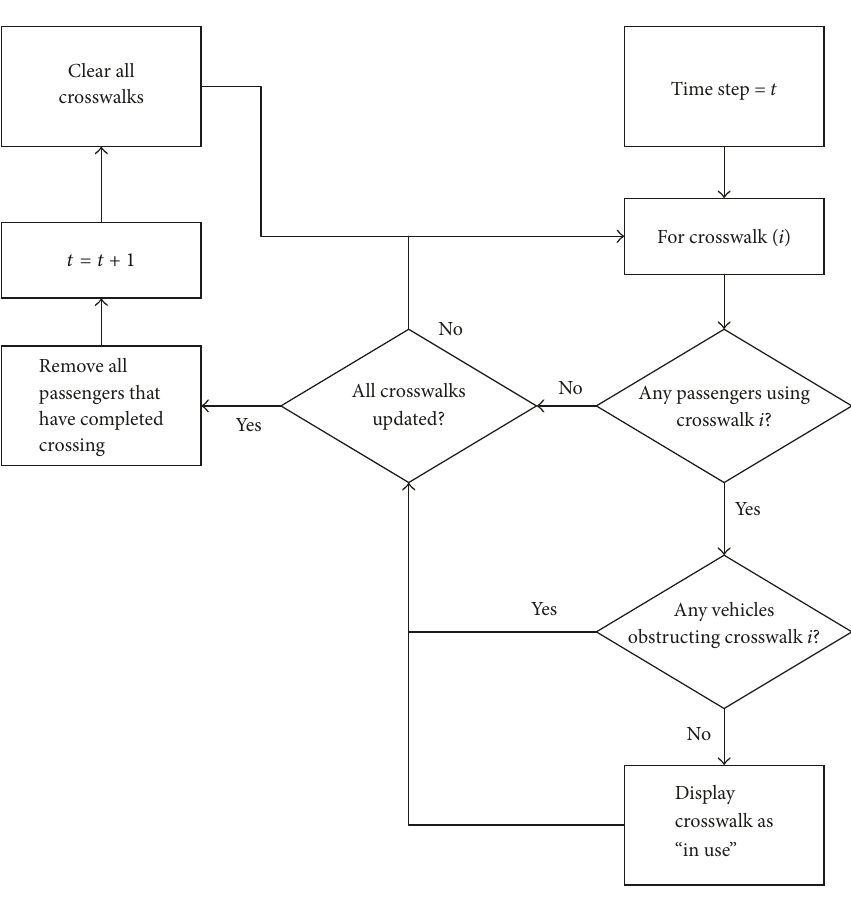
Figure 8: Algorithm for crosswalks.